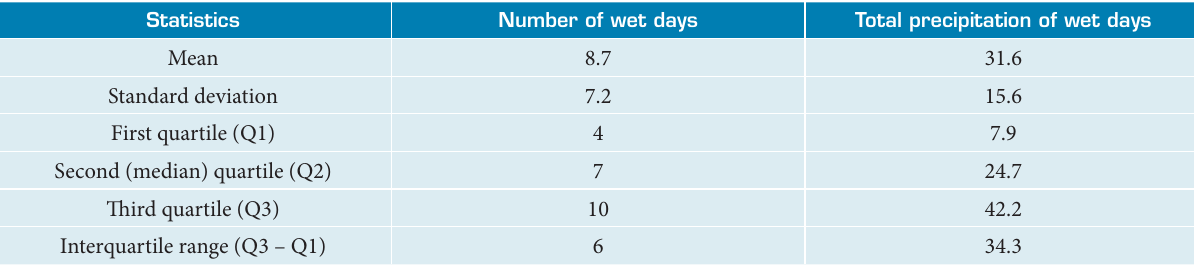
Table 1. Statistics of the number and the total precipitation of wet days for the entire quarter (SON). Period: 1979-2016, except 2006 (37